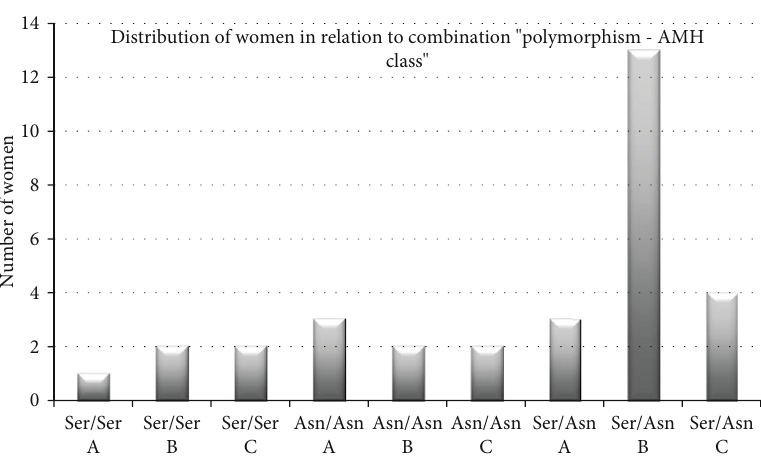
Figure 1: Distribution of women in relation to the combination “ polymorphism-AMH class ” ( p value 0.399). Class A corresponds to menopause-related AMH values (0-0.44ng/ml), class B corresponds to subfertility AMH values (0.44-2.22ng/ml), and class C symbol corresponds to normal AMH values (2.22